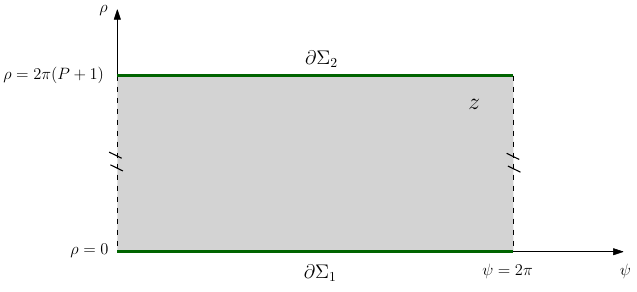
Figure 3 . Riemann surface associated to our AdS 2 geometries. Given the periodicity of ψ it defines an